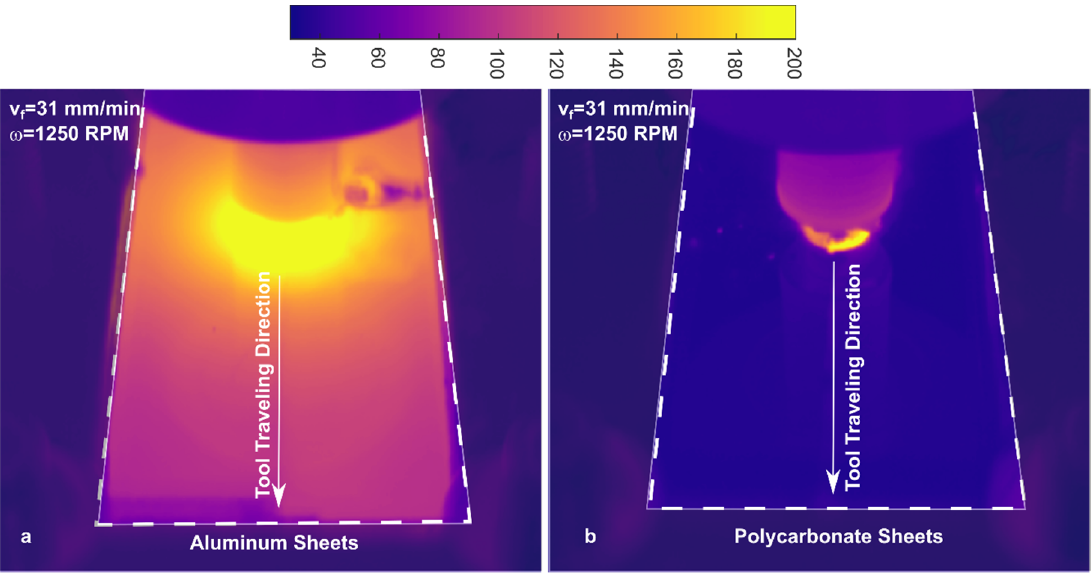
Figure 4. Temperature distribution during FSW of: ( a ) aluminum [14] and ( b ) polycarbonate [15].